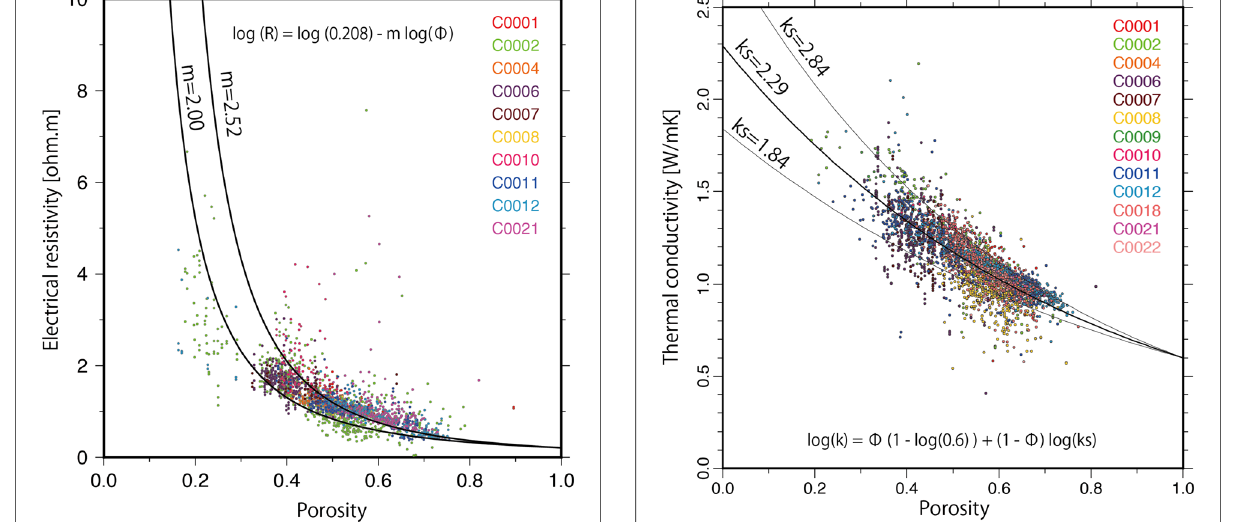
Fig. 6 Correlation between XCT-derived porosity and electrical resistivity